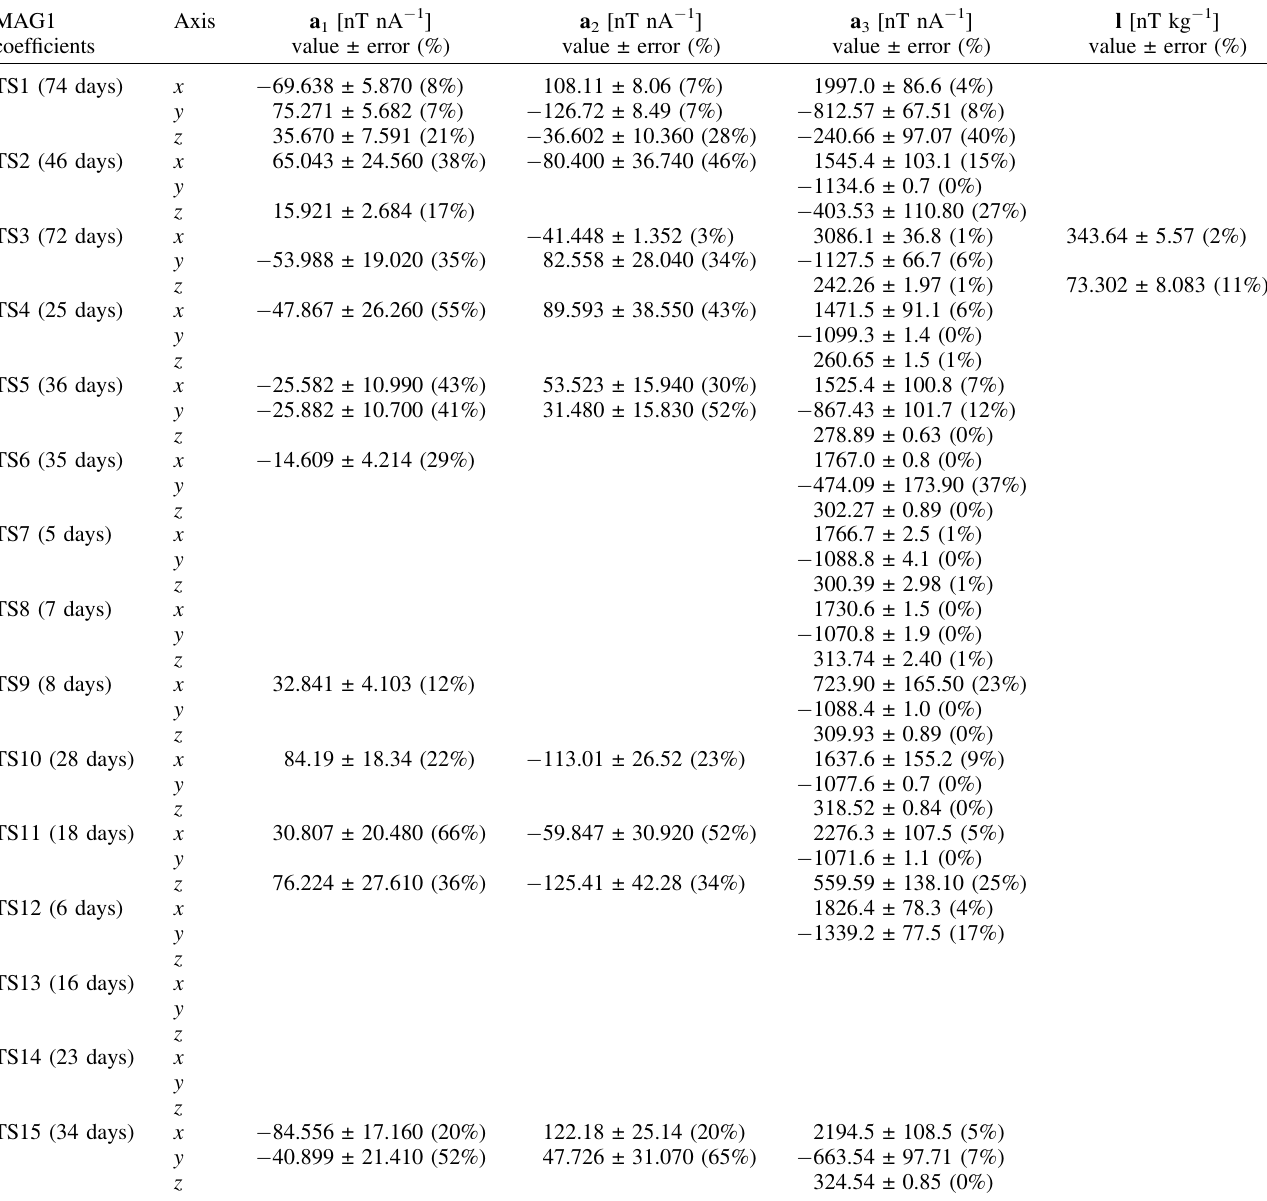
Table 3. MCMC parameter and parameter uncertainty estimates obtained by performing a joint fi t on the measurements of the MX magnetometer. The parameters appear in equation